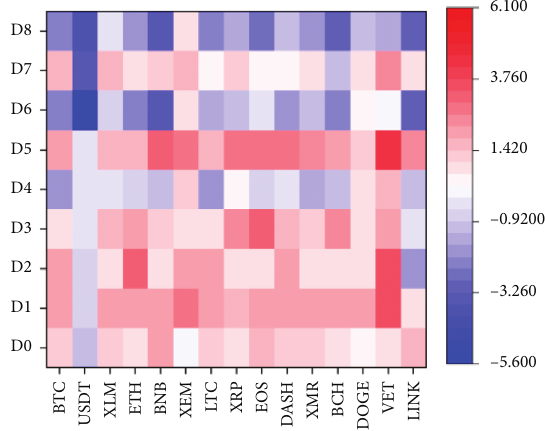
Figure 25: THETA to the other. Table 4: DY index under D1.